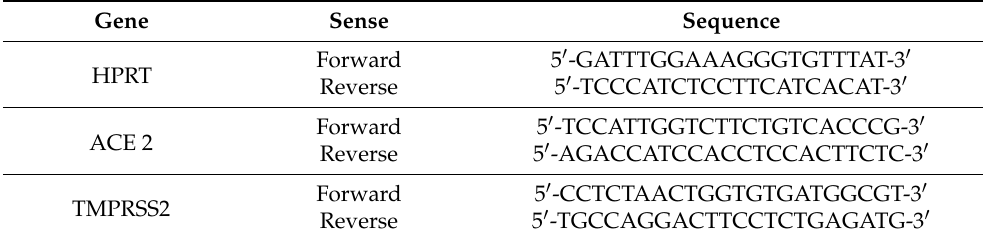
Table 3. Primers used to verify the correct cell morphology receptors.